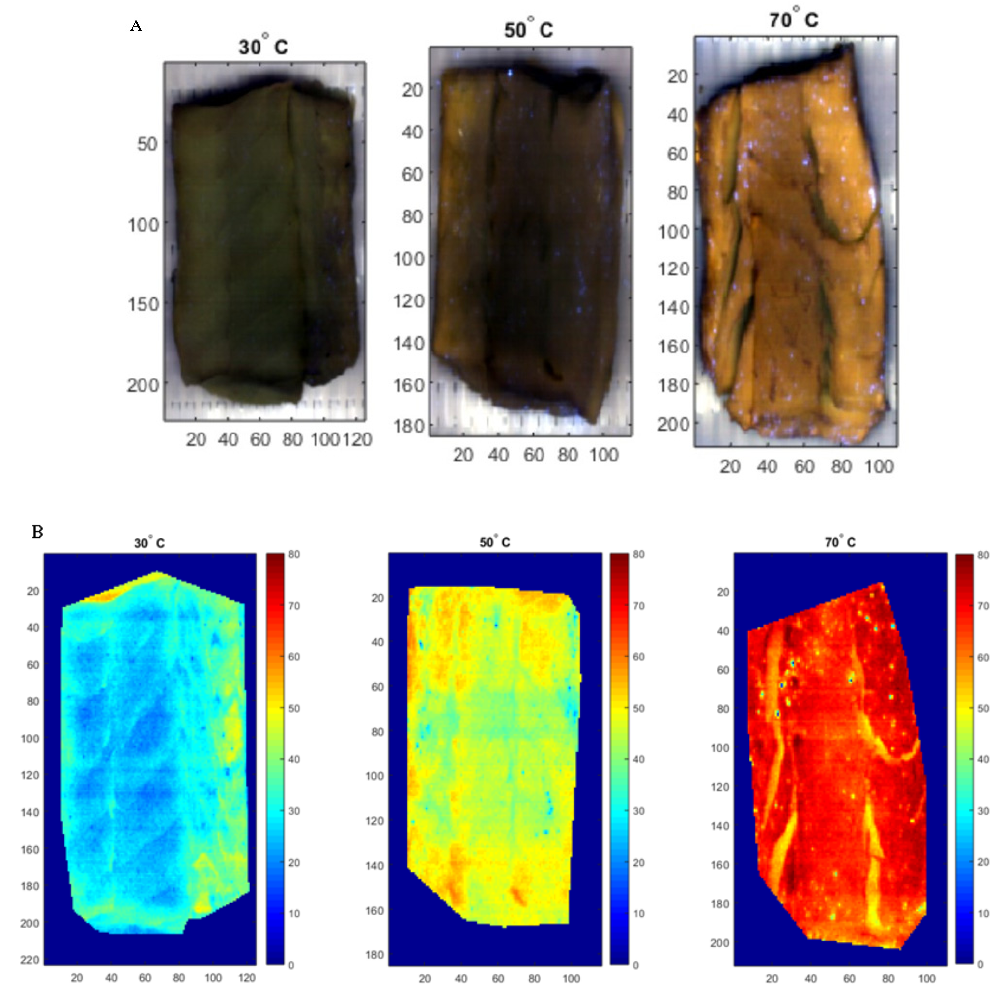
Figure 4. Examples of pseudo green red blue (RGB) images of cod fillets cooked at three different temperatures (30, 50, and 70 °C) and measured by fluorescence hyperspectral imaging ( A ); Pixel-wise estimates of temperature, visualizing the temperature distribution in the fillets ( B ).